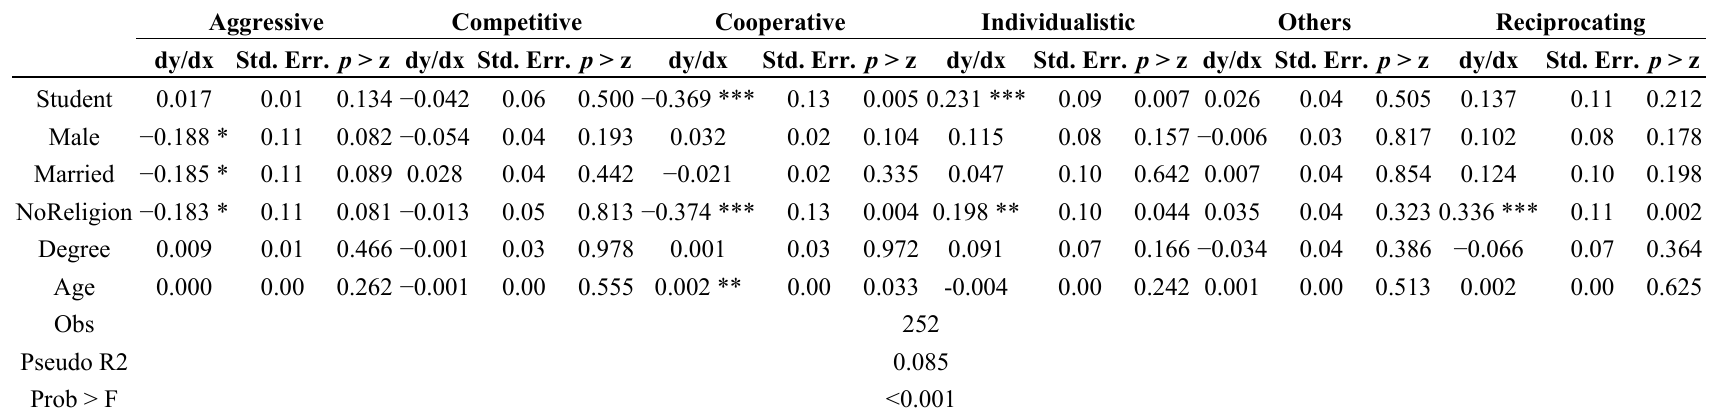
Table A13. Multinomial logit (Strategy